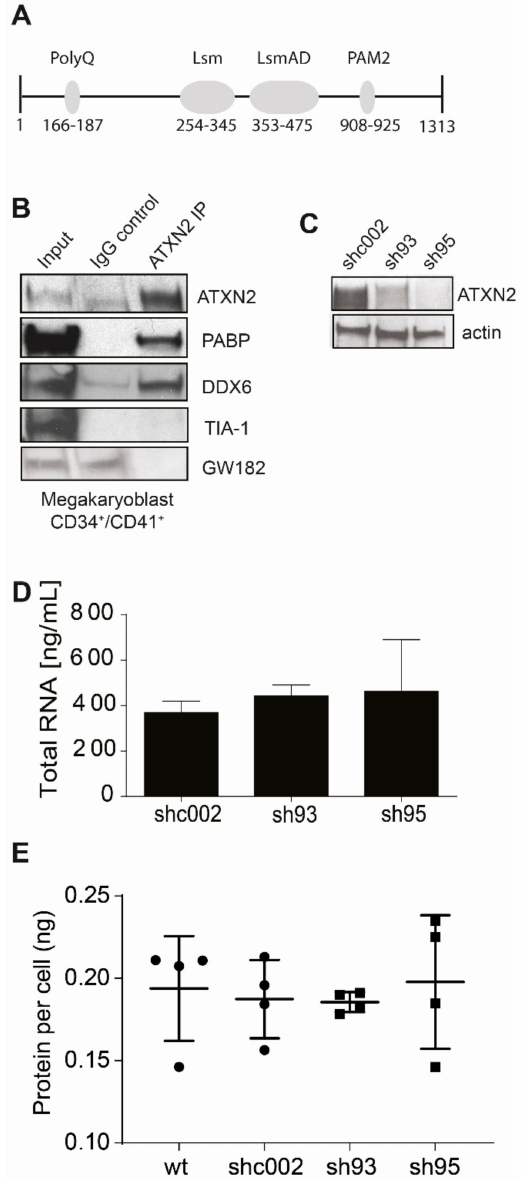
Figure 2. ATXN2 associates with proteins implicated in mRNA storage and decay. ( A ) Schematic representation of functional domains within ATXN2, positions indicate amino